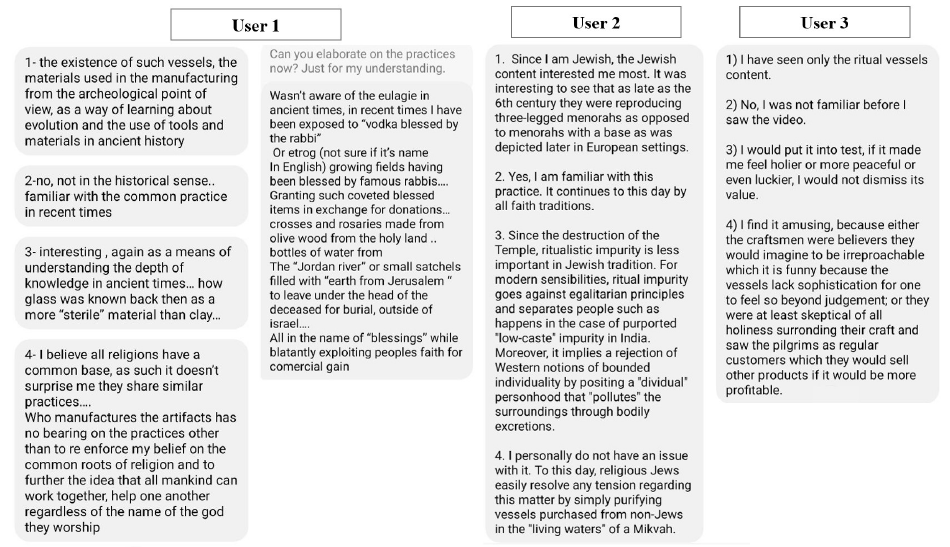
Figure 7. A sample of responses to four questions for the content shared on the Glass Jar artefact received via Facebook.